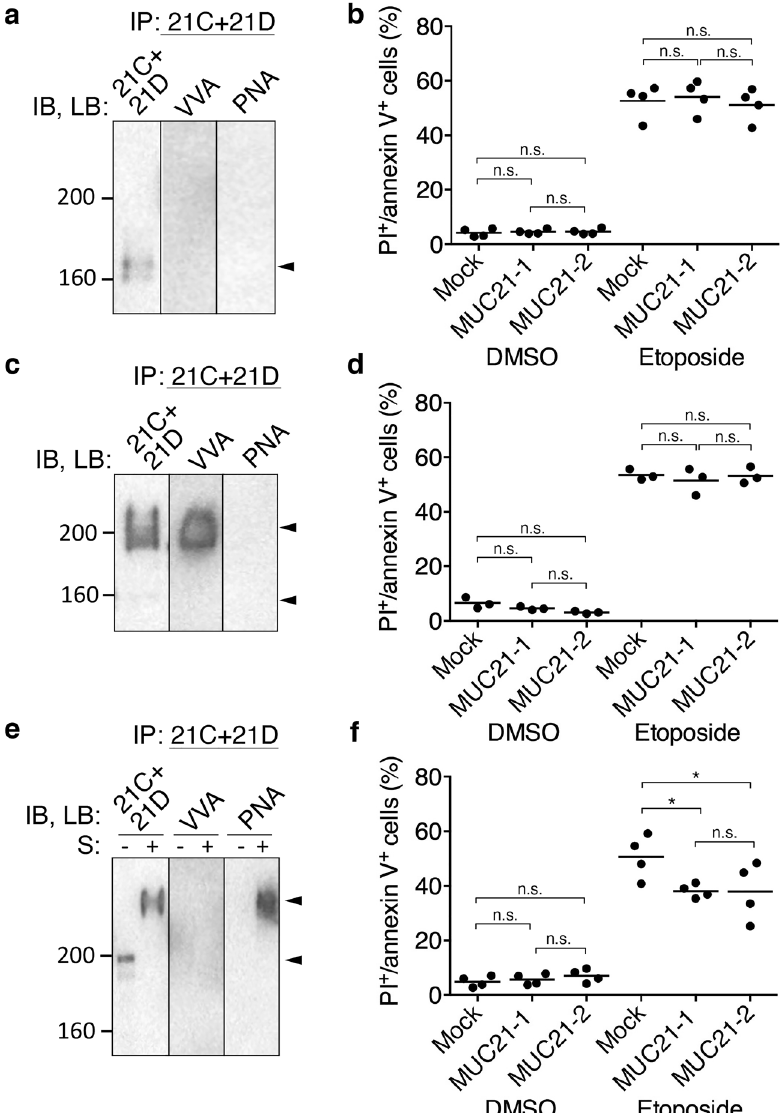
Fig. 6 Glycosylation and antiapoptotic effects of MUC21 expressed on CHO-ldlD cells grown in different culture media. a Electrophoretic and lectin-binding pro fi les of full-length MUC21 expressed by CHO-ldlD cells grown in regular culture medium. In the middle and right panel, MUC21 was immunoprecipitated with a 1:1 mixture of mAbs heM21C (21C) and heM21D (21D), electrophoretically separated, and blotted. In the left panel, the blotted membrane was stained with a 1:1 mixture of mAbs heM21C and heM21D. In the middle and right panel, the membrane was reacted with biotinylated VVA and biotinylated PNA, respectively. The arrow head tentatively indicates the position of nonglycosylated MUC21. b Percentage of apoptotic CHO-ldlD cells transfected with full-length MUC21 (clones MUC21-1 and MUC21-2) or mock transfectant grown in regular culture medium after treatment with 250 μ M etoposide for 48 h as determined by PI staining and binding of annexin V. Four independent experiments are shown. c Electrophoretic and lectin-binding pro fi les of full-length MUC21 expressed by CHO- ldlD cells grown in culture medium supplemented with 1 mM GalNAc. In the middle and right panel, MUC21 was immunoprecipitated with a mixture of mAbs heM21C and heM21D, electrophoretically separated, and blotted. In the left panel, the blotted membrane was stained with a 1:1 mixture of mAbs heM21C and heM21D. In the middle and right panel, the membrane was reacted with biotinylated VVA and biotinylated PNA, respectively. The arrowheads tentatively indicate the position of Tn-MUC21 (top) and nonglycosylated MUC21 (bottom). d Percentage of apoptotic CHO-ldlD cells transfected with full-length MUC21 or mock transfectants grown in culture medium supplemented with 1 mM GalNAc after treatment with 250 μ M etoposide for 48 h as determined by PI staining and binding of annexin V. Three independent experiments are shown. e Electrophoretic and lectin-binding pro fi les of full-length MUC21 expressed by CHO-ldlD cells grown in culture medium supplemented with 1 mM GalNAc and 25 mM Gal. In all panels, cells were used untreated (S: − ) or after treatment with sialidase (S: + ). MUC21 was immunoprecipitated with a mixture of mAbs heM21C and heM21D, electrophoretically separated, and blotted. In the left panel, the blotted membrane was stained with a mixture of mAbs heM21C and heM21D. In the middle and right panel, the membrane was reacted with biotinylated VVA and biotinylated PNA, respectively. The arrowheads tentatively indicate the position of sialidase-treated (top) and -untreated (bottom) sialyl T-MUC21. f Percentage of apoptotic CHO-ldlD cells transfected with full-length MUC21 or mock transfectants grown in culture medium supplemented with 1 mM GalNAc and 25 mM Gal after treatment with 250 μ M etoposide for 48 h as determined by PI staining and binding of annexin V. Four independent experiments are shown. The mean is indicated as a horizontal line. Two-way ANOVA with Tukey ’ s multiple-comparison test. n.s.: not signi fi cant, * p < 0.05. IP: immunoprecipitation, IB: immunoblot, LB: lectin blot, S: sialidase treatment, PNA: peanut (Arachis hypogaea) agglutinin, VVA: Vicia villosa agglutinin.